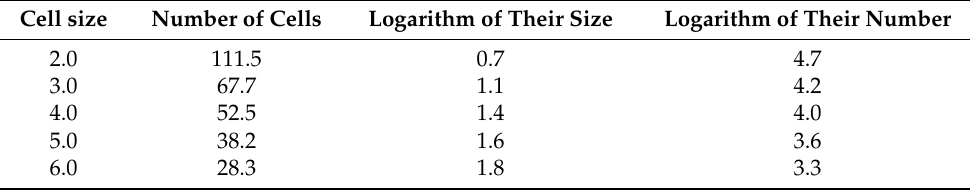
Table 2. The correspondence between the size of the grid cells and the number of cells.